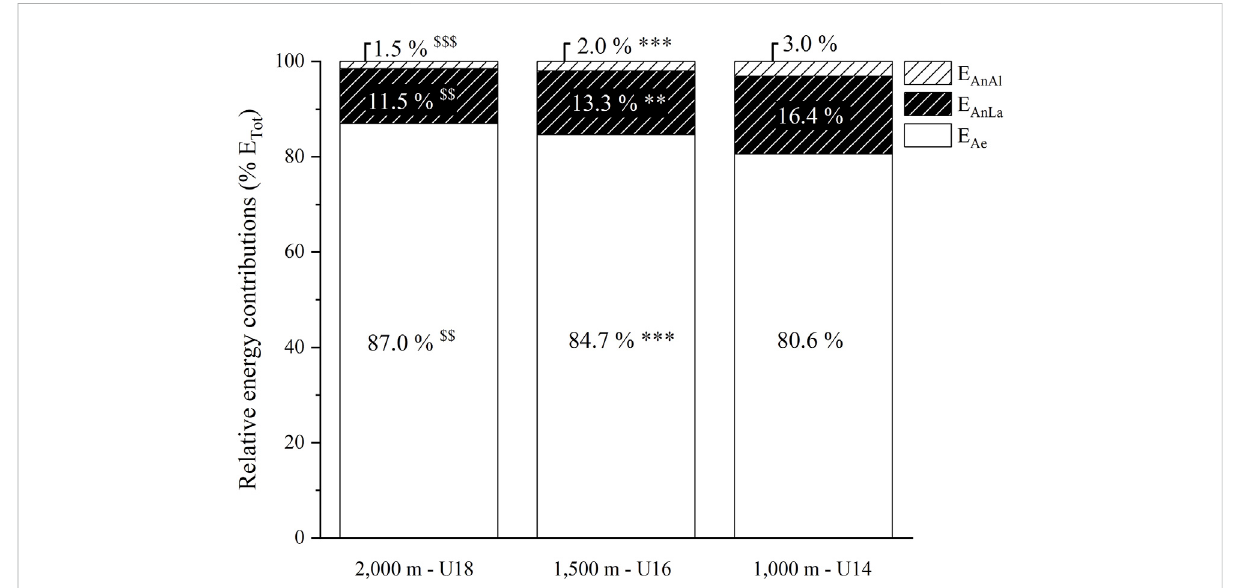
FIGURE 3 Relative aerobic and anaerobic (alactic and lactic) energy contributions(%E Ae and %E AnAl and %E AnLa ,respectively) expressed as apercentageof total energy released (E Tot ) during the exhaustive rowing ergometer exercise over 2,000 m in rowers under 18 years (U18, n = 9), 1,500 m in rowers under16 years(U16,n=10)and1,000 minrowersunder14 years(U14,n=12). $$ and $$$ :signi fi cantlydifferentbetweenU18andU16at p < 0.01and p < 0.001, respectively. ** and ***: signi fi cantly different between U16 and U14 at p < 0.01 and p < 0.001,